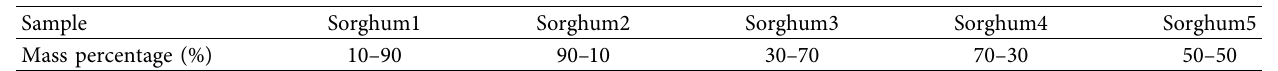
Table 2: Mass percentages of japonica sorghum and glutinous sorghum in mixture